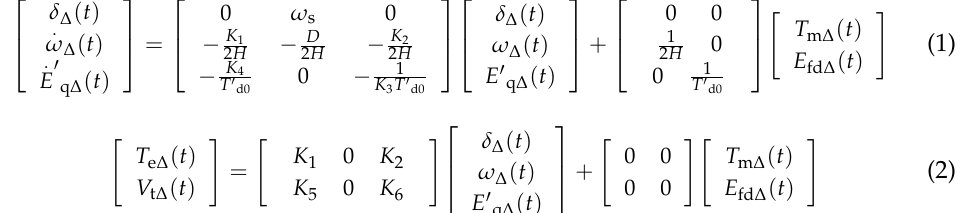
The variables in Table 2: δ ( t ) is the electric rotor angle; V d ( t ) and V q ( t ) are stator terminal d- and q-axis voltages, respectively; I d ( t ) and I q ( t ) are the stator d- and q-axis currents, respectively; and E , E qa , and E ’ q are standardized phasor diagram EMFs. Index op means an operating point